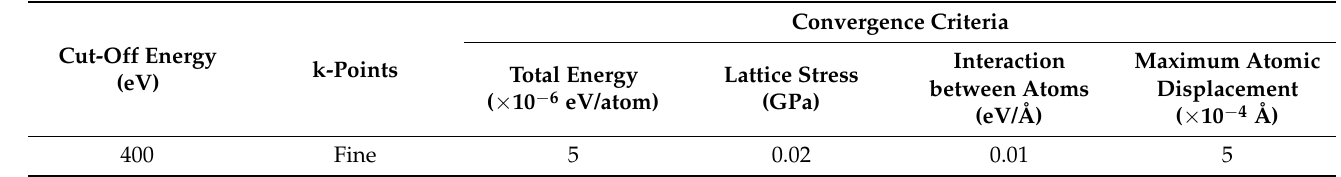
Table 1. Computational parameters for density functional theory (DFT) simulations.